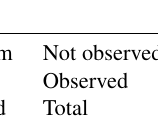
Table 4. Categorical score definitions for a binary event. Observed and forecasted No Yes No Correct non-event False alarm Not observed Yes Miss Hit Observed Not forecasted Forecasted